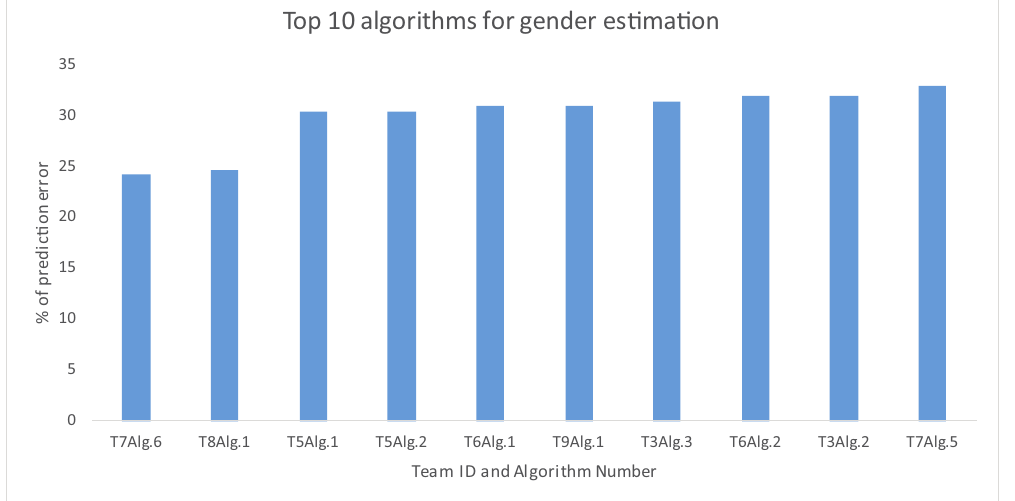
Figure 9. Top 10 algorithms, irrespective of any team to predict errors for gender estimation. ‘T’ stands for ‘Team’ and ‘A’ stands for ‘Algorithm’.